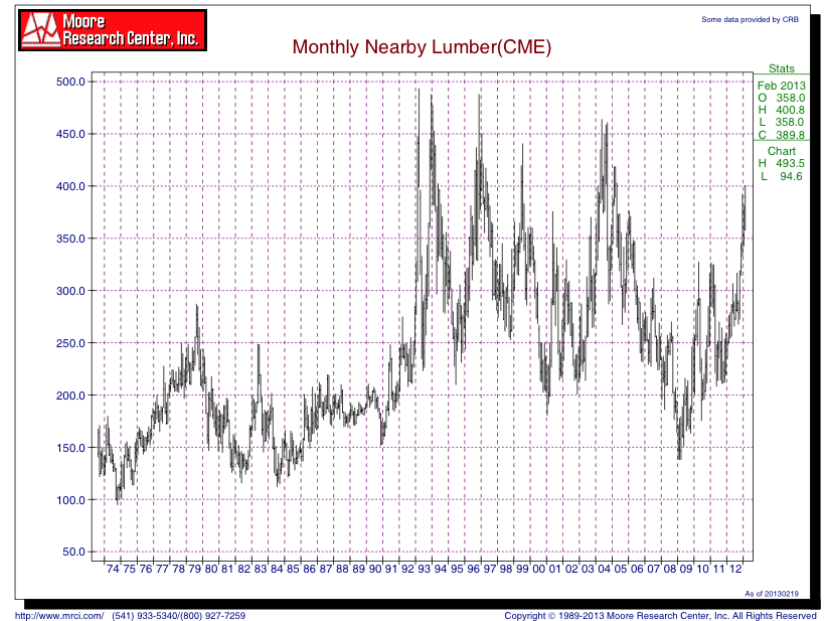
Figure 2. Monthly Nearby Lumber (CME) prices (US$/1000 board feet) which tracks the framing lumber composite price in the United States, with no adjustment for